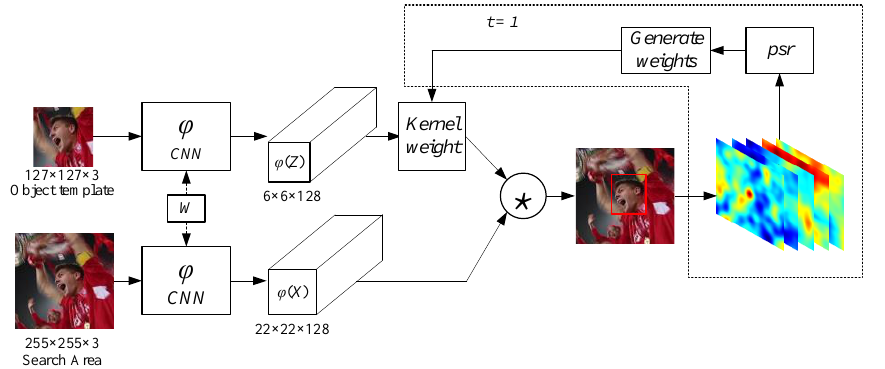
Figure 10. The SiamFCCA object tracking architecture.